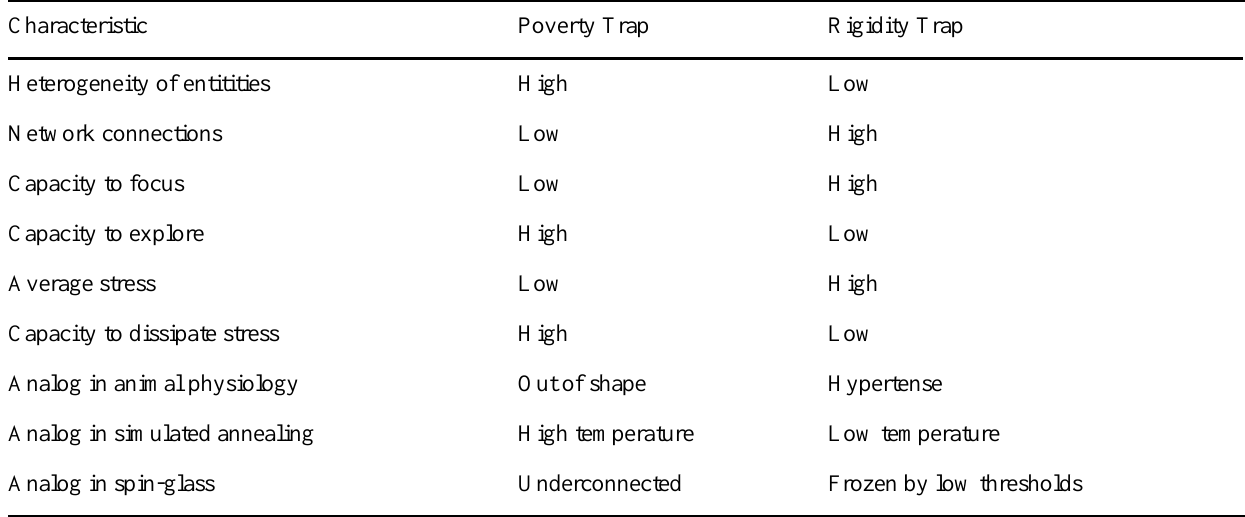
Table 1. Characteristics of the traps.